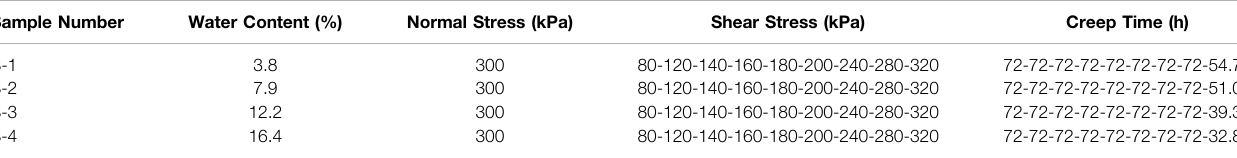
TABLE 1 | Shear stress loading scheme for the creep test. Sample